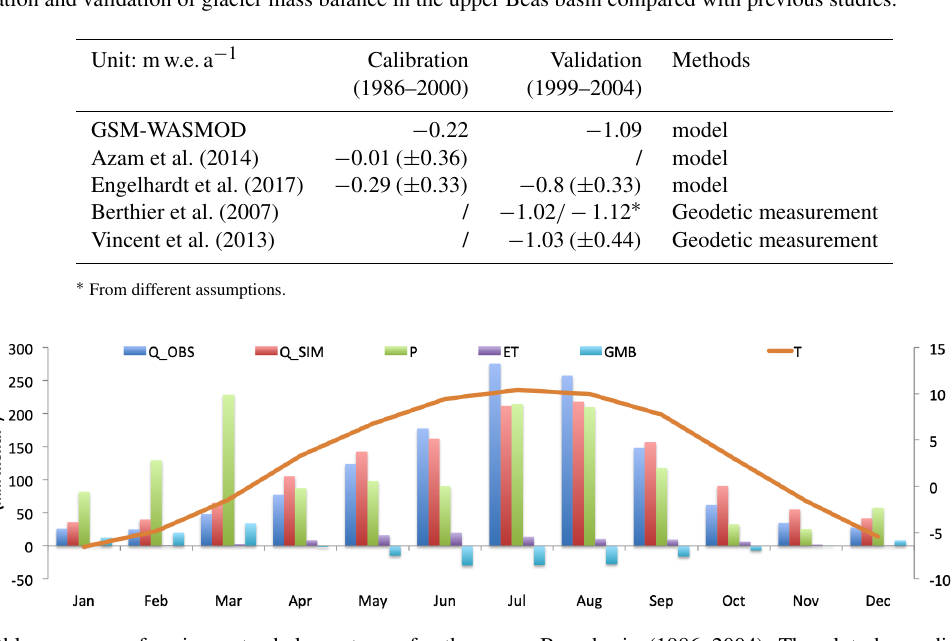
Table 4. Calibration and validation of glacier mass balance in the upper Beas basin compared with previous studies.